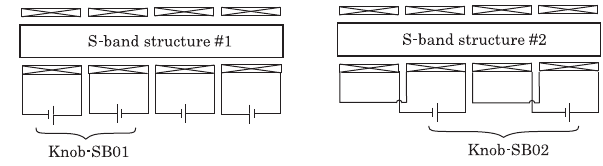
FIG. 9. S-band structures with solenoid magnets and their cabling (schematic). We use two pairs of power supplies ( Knob- SB01 and Knob-SB02 ) for the correction by applying asymmetric excitation, i.e., I n (cid:1) I c , where I n is the nominal current and I c is the correction current.